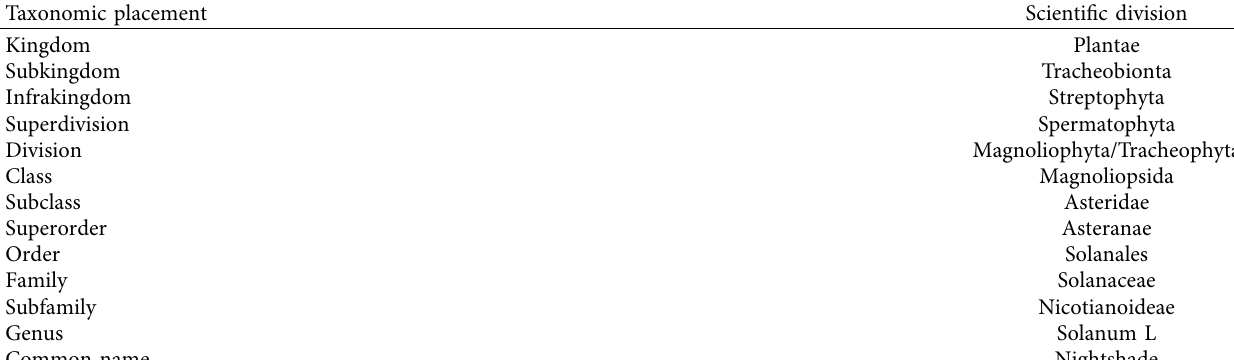
Table 1: Taxonomy of Solanaceae family.